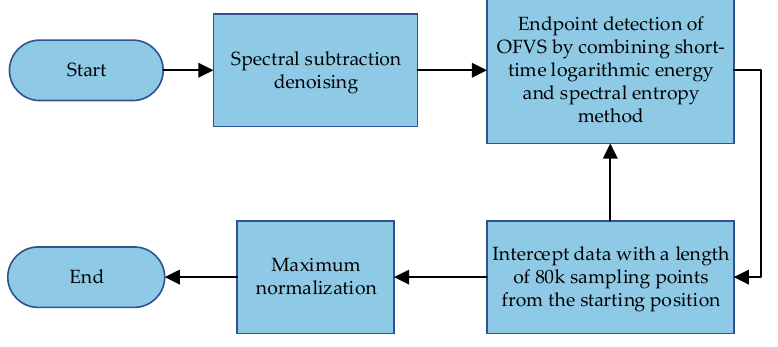
Figure 5. Signal preprocessing flow chart.